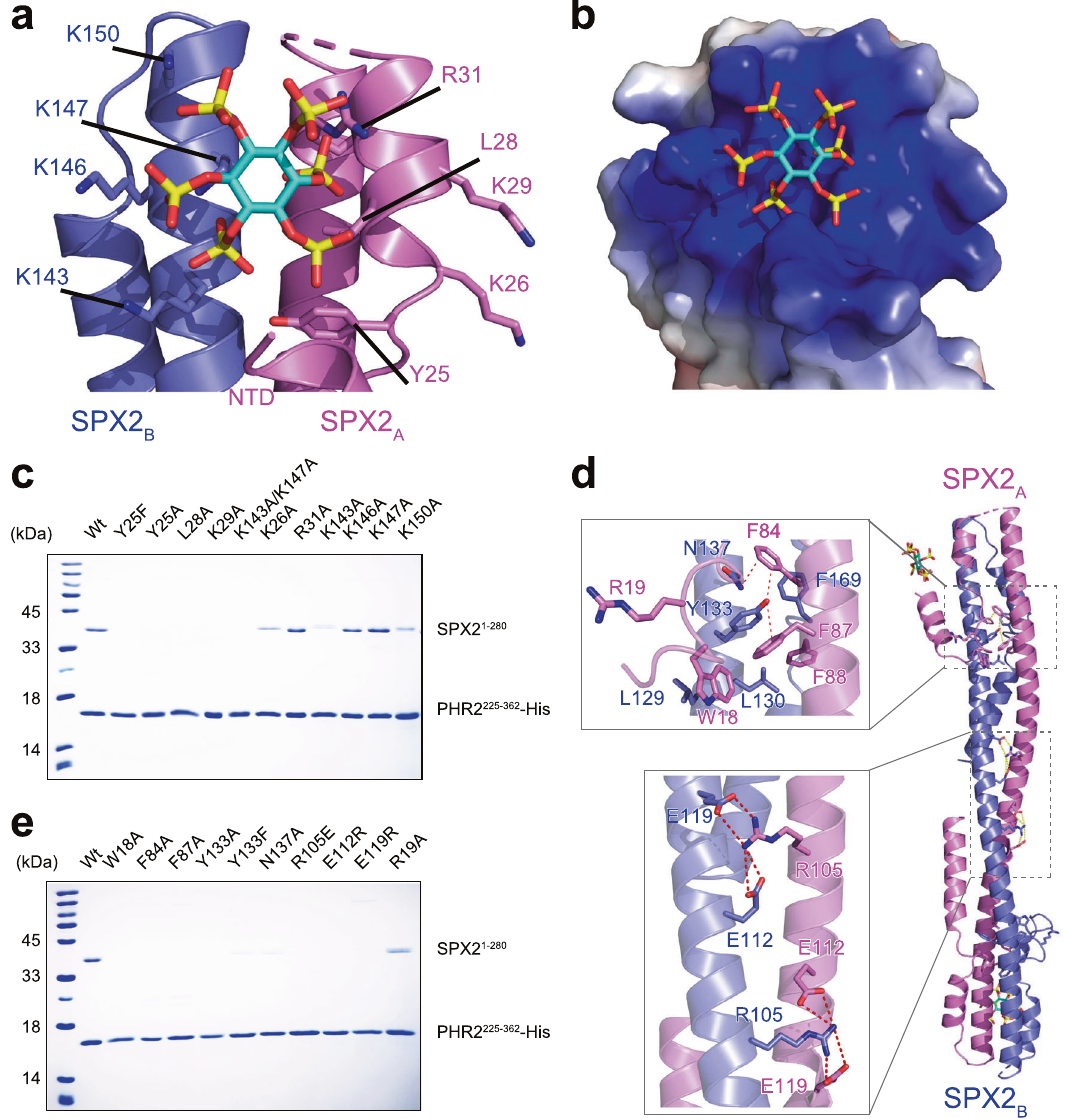
Fig. 2 The recognition of InsP 6 by the domain-swapped rice SPX2 dimer in the SPX2/InsP 6 /PHR2 complex. a Binding surface of InsP 6 in the SPX2 dimer. b The electrostatic surface of the InsP 6 binding surface, colored in terms of electrostatic potential, and displayed in a scale from red ( − 5 kT/e) to blue ( + 5 kT/e). c Co-expression coupled Ni-NTA pull-down assess the InsP 6 -binding dependent SPX2 – PHR2 association. Experiments were independently repeated three times with similar results. d Interface of the SPX2 dimer. PHR2 has been omitted for clearity. e Co-expression coupled Ni-NTA pull-down assess the SPX2 dimerization for SPX2/PHR2 association. Experiments were independently repeated three times with similar results. For the pull-down assay, different mutated versions of the full length SPX2 1 – 280 and His-tagged PHR2 225 – 362 were co-expressed in the presence of 1 mM InsP 6